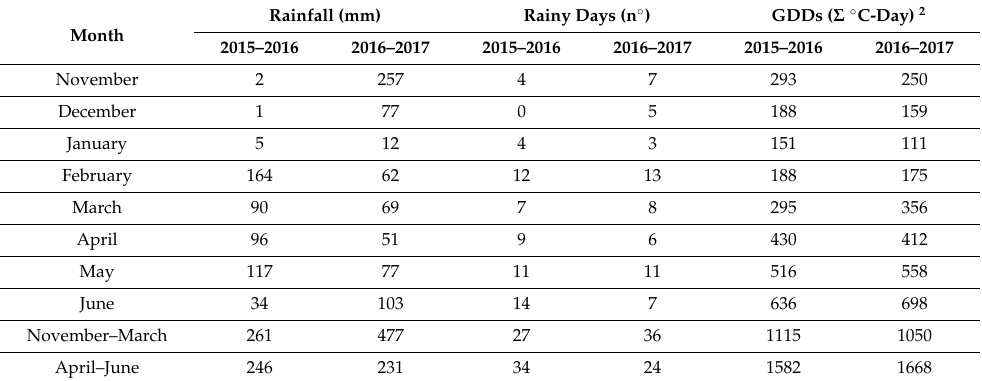
Table 1. Monthly cumulative rainfall, rainy days, and growing degree days (GDDs) 1 measured in the experimental areas from sowing (November) to harvesting (June) in the 2015–2017 period. Rainfall (mm) Rainy Days (n ◦ ) GDDs ( Σ ◦ C-Day) Month